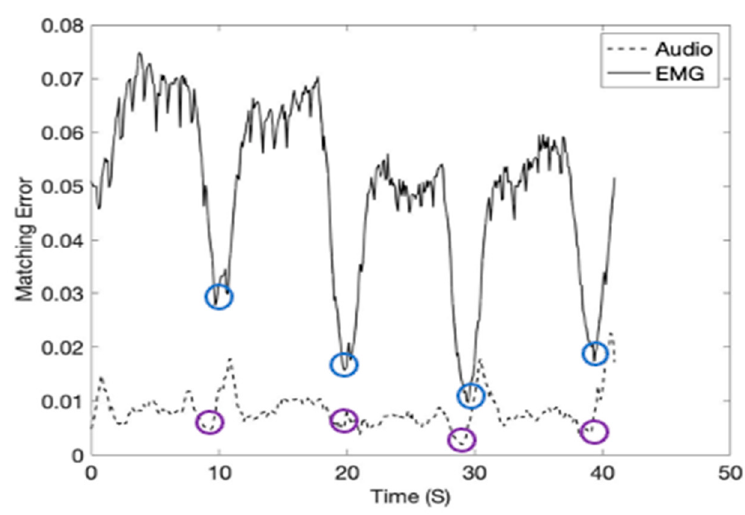
Figure 10. The breathing cycles (i.e., inspiration moments) monitored using the template signature matrices. The sensor signals were obtained from the EIM location (1000 mL tidal volume).